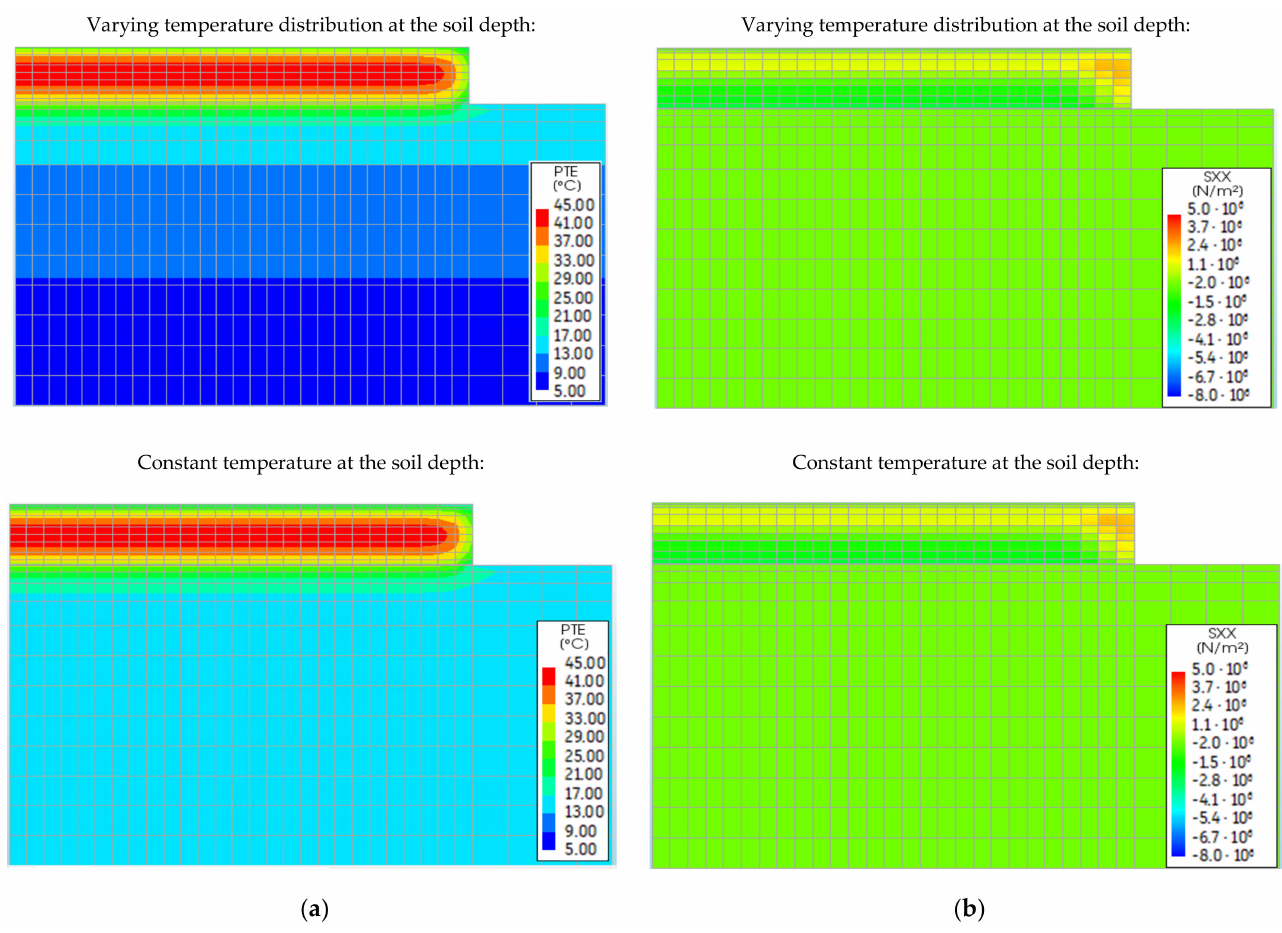
Figure 20. The effect of the initial soil temperature on the distributions of ( a ) temperature and ( b ) stress σ xx .